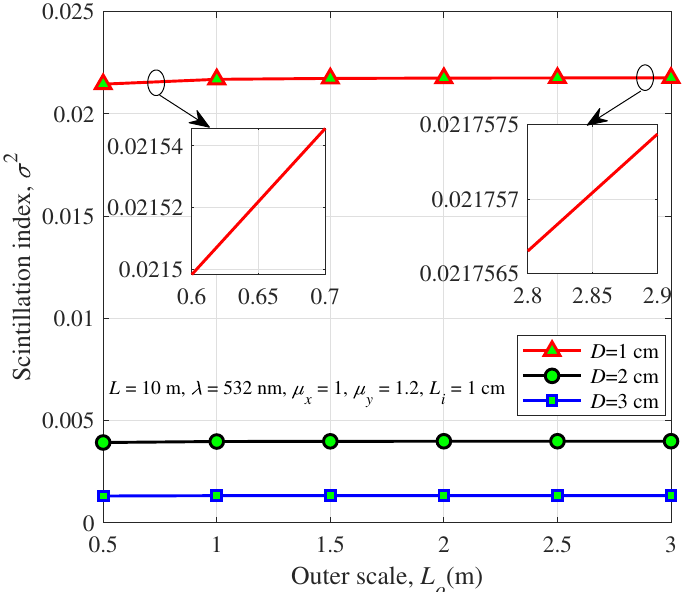
Figure 2. Scintillation index of a spherical wave versus the outer scale for different aperture diameters.